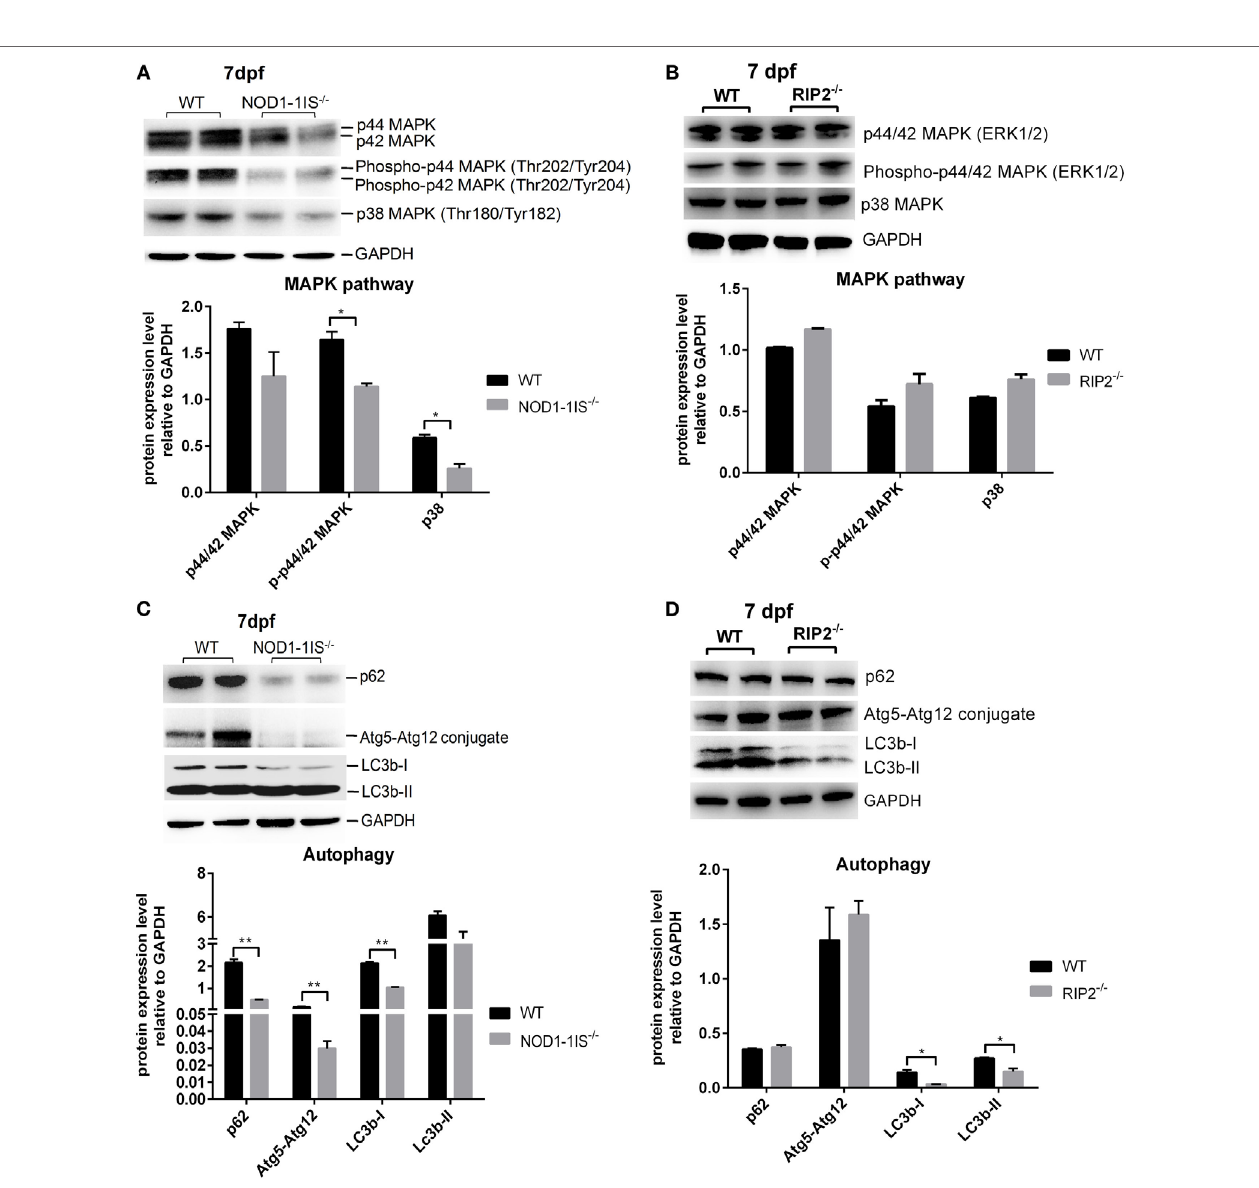
FigUre 5 | RIP2 is a critical regulator for NLRs signaling. (a) The gene cluster for “NOD-like receptors.” At the top of this panel, a color key denotes the gradient scale of gene expression from low (green) to high (red) degrees. (B) Phylogenetic tree of NOD-like receptors. Phylogenetic relationships were based on amino acid alignments. Bootstrap values based on 10,000 replicates are indicated on each branch. The evolutionary history was inferred using the neighbor joining method. All positions containing gaps and missing data were eliminated from the dataset (pairwise deletion). Accession numbers of other NLR sequences from NCBI databases are as follows: zebrafish NOD2, NP_001314973; zebrafish NOD3, XP_003201049; zebrafish NLRC5, XP_003200494; human NLRC3, ACP40993; human NLRC5, NP_115582; human NOD1, AAD28350; and human NOD2, AAG33677. (c) The expression changes of NLRs in the RIP2 knockout zebrafish compared with WT. 30–50 larvae from WT and RIP2 − / − zebrafish were collected at 7 days post-fertilization and used for quantitative real-time PCR (qRT-PCR). Data represent the mean ± the SEM, and were tested for statistical significance using two-tailed Student’s t -test. ** p < 0.01. Those genes with the same expression tendency between RNA-seq and qRT-PCR are indicated by “ √ ” in red. (D) The expression changes of NLRs in the RIP2-overexpressed zebrafish compared with that transfected with empty plasmid. 30–50 embryos or larvae from ptGFP1-transfected and RIP2-transfected zebrafish were collected at 48 h post transfection and used for qRT-PCR. Data represent the mean ± the SEM, and were tested for statistical significance using two-tailed Student’s t -test. ** p <